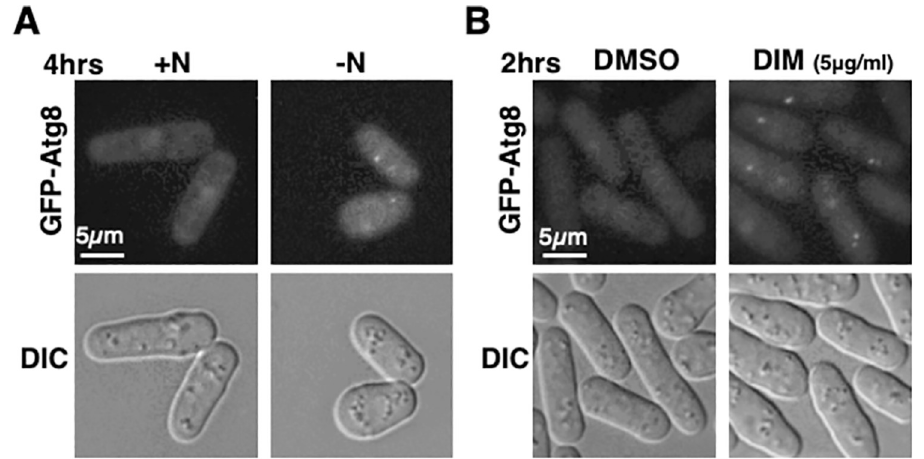
concentration (5 μ g/ml) of 3,3’-Diindolylmethane (B). GFP-Atg8 foci were used as markers for autophagy induction. See materials and methods for detailed condition of cell